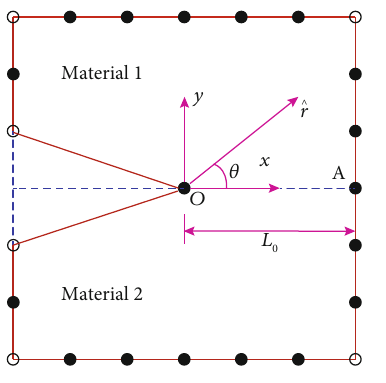
Figure 2: Polygon representation of SBFEM